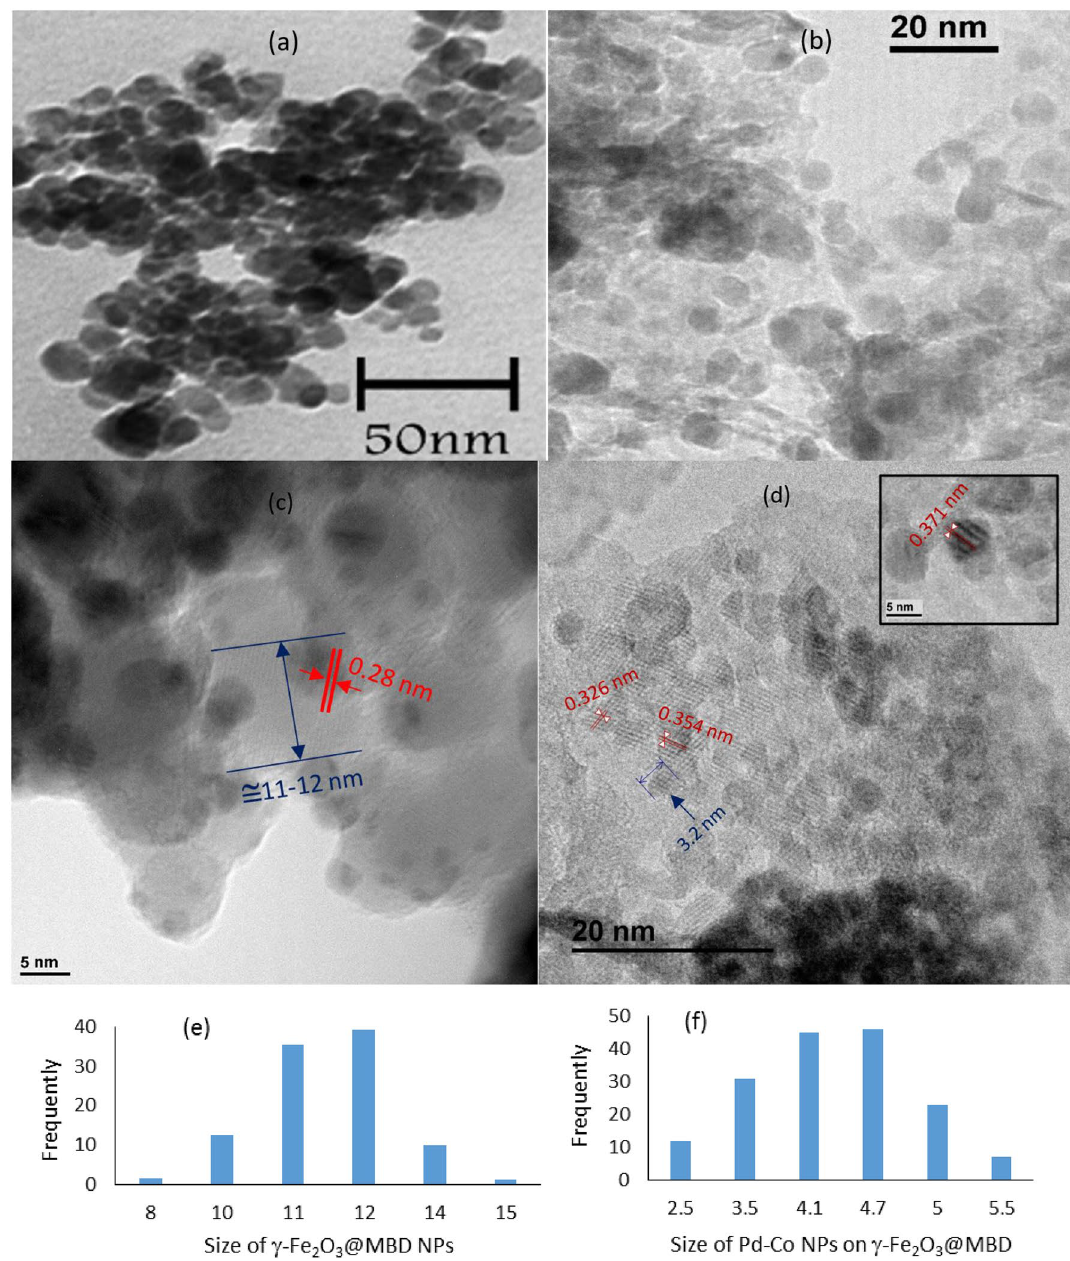
Figure 6. The TEM images of ( a ) γ-Fe 2 O 3 and ( b – d ) γ-Fe 2 O 3 @MBD/Pd-Co and ( e ) the particle size distribution of